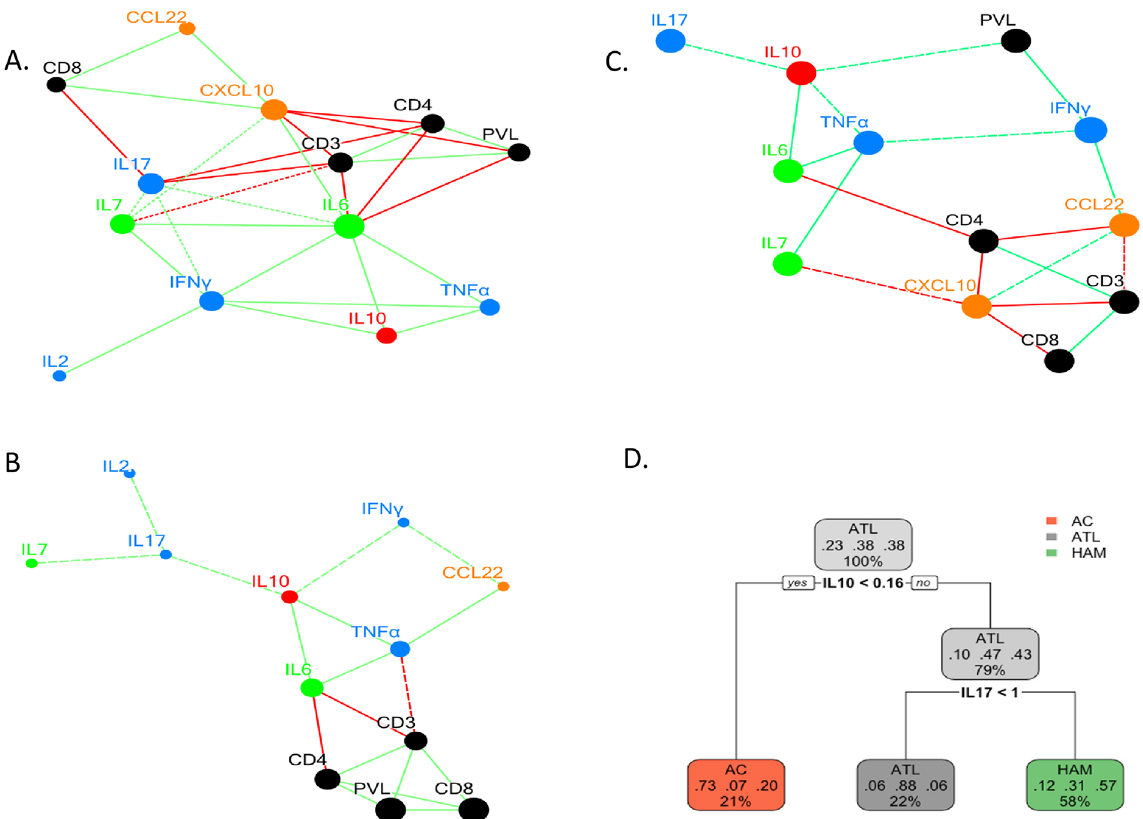
Fig 3. Network and classification tree analysis of plasma cytokine concentration in non-ATL HTLV-1 infection and ATL. Network analysis of absolute T-cell subset count, HTLV-1 PVL and plasma cytokine concentration using at least significant Spearman correlation trends is shown for patients with ATL (A), HAM (B) and AC (C). The green and red lines denote positive and negative correlations respectively. The continuous and broken line denote statistically significant and trend correlations. The prune classification tree to classify diagnosis of AC, HAM and ATL on the basis of IL-10 and IL-17 concentration is shown in figure D. The percentage shows the distribution of all patients into different arms whilst the three decimal numbers shown specificity of each classification for diagnosis of AC, ATL and HAM respectively.